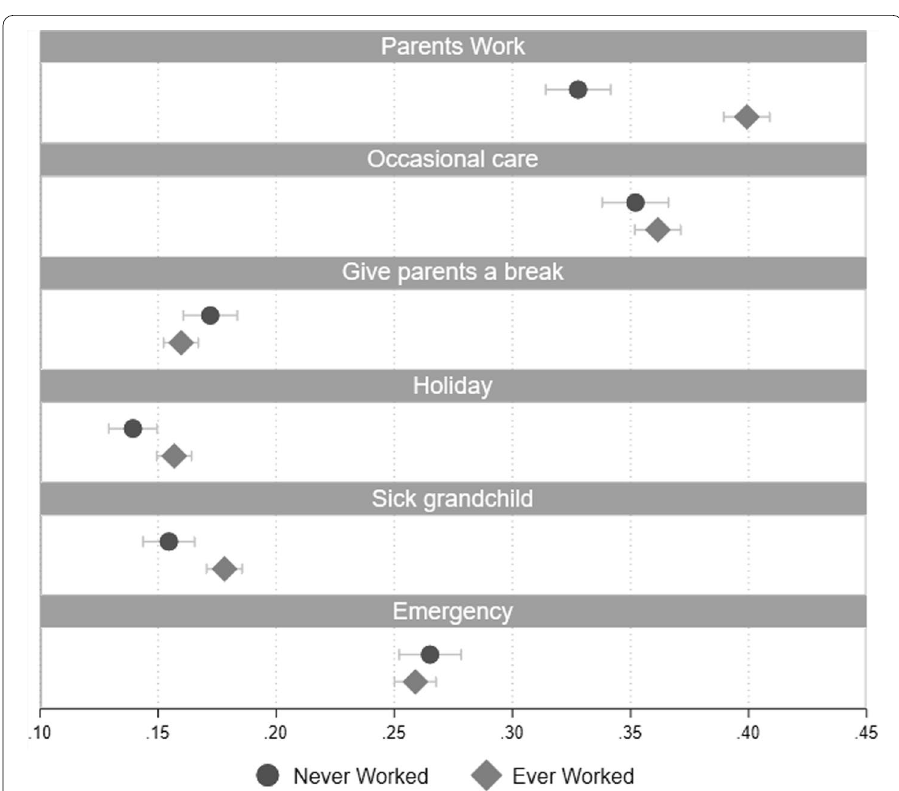
Fig. 3 Predicted probabilities ( x -axis) to perform grandparental childcare under different circumstances, by grandmothers’ work history: Having ever worked (no/yes). Results from logistic regression models, control variables included: age; occupational status; birth cohort; educational level; area of residence. CI for approximate 5% significance level for the comparison of pairs of predicted probabilities. Source : Authors’ elaborations on Multipurpose surveys on Families and Social Subjects— ISTAT, 2003, 2009, 2016. N